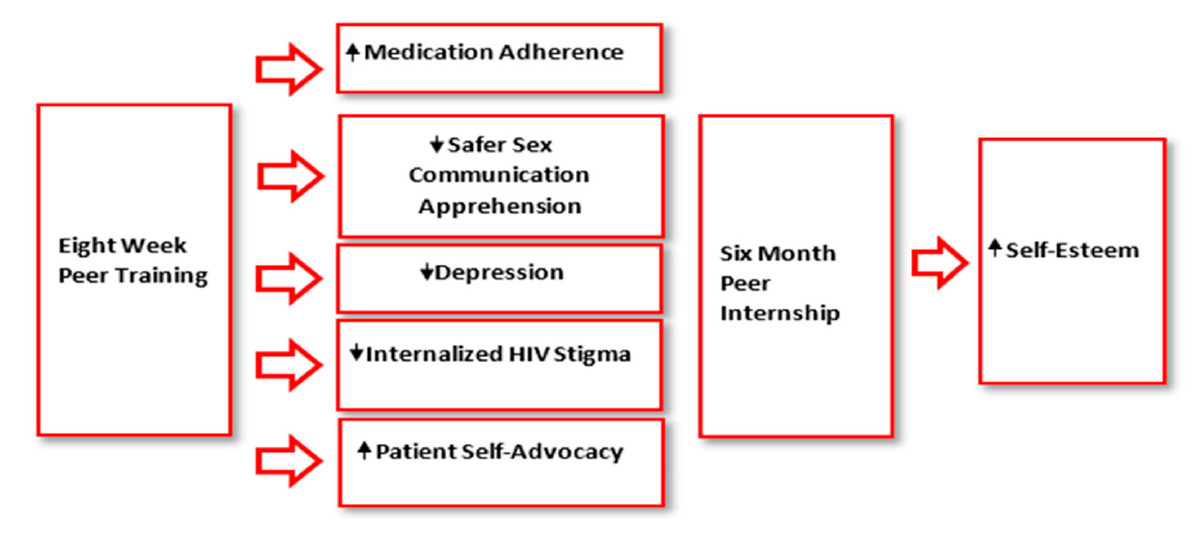
Figure 1. Paths of psychosocial change. Table 1. Participants by cohort and survey completion (N =